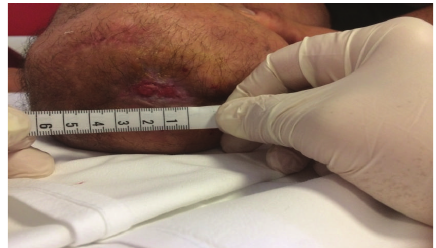
Figure 3: Stage III at 3rd week.